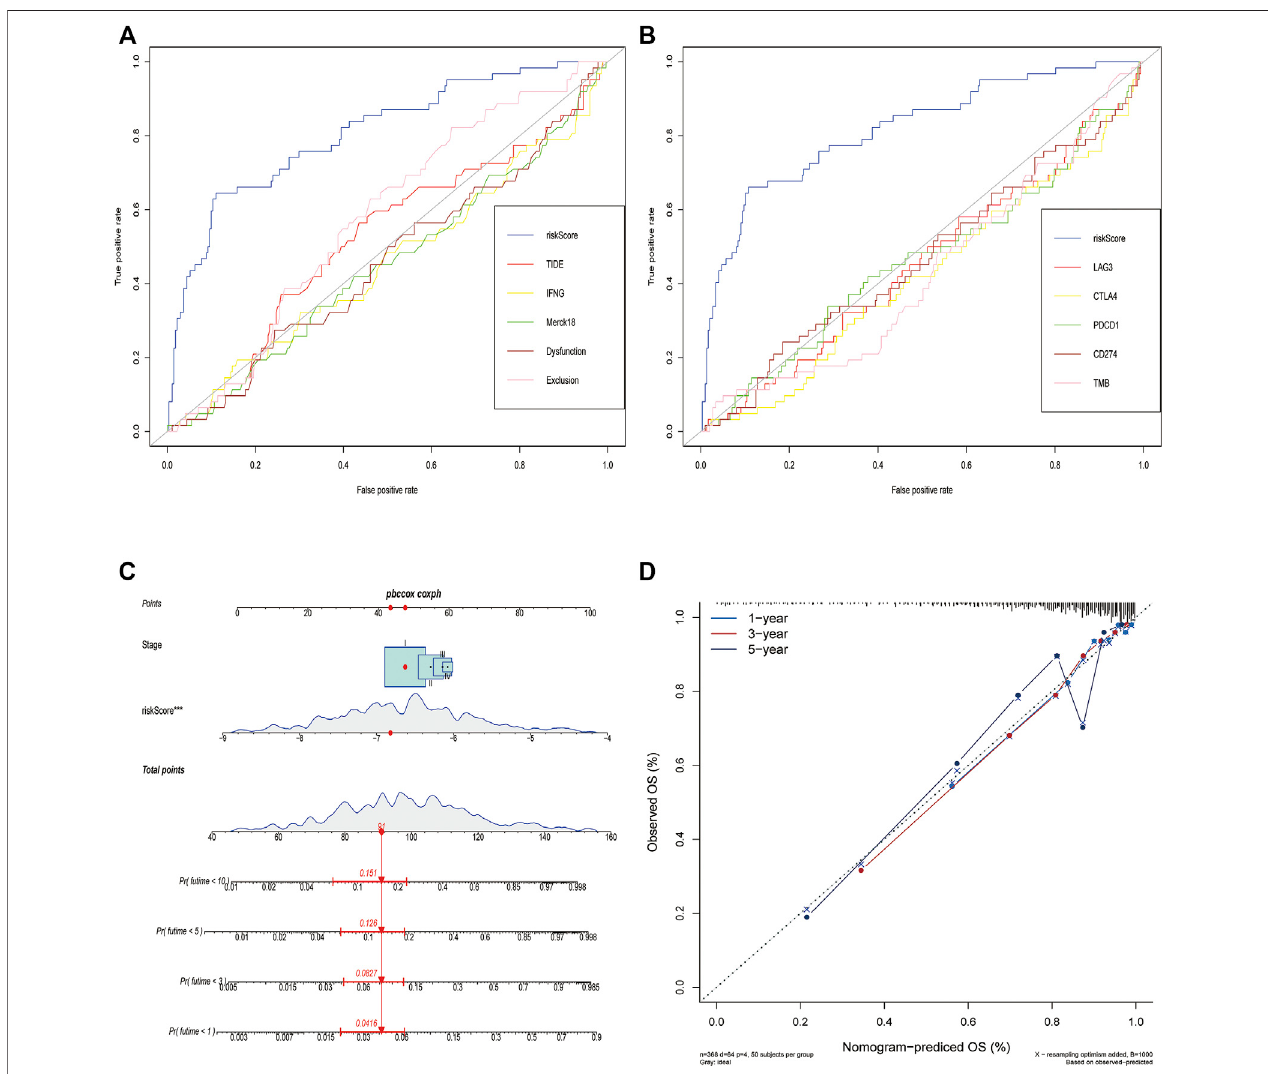
FIGURE 8 | Comparison of the predictive power of PCD-related signature with other biomarkers and construction of a nomogram in TCGA cohort. (A,B) ROC curve compared the sensitivity and speci fi city of risk score and other biomarkers for predicting OS. (C) Nomogram combined the TNM staging and risk score for predicting the 1-, 3-, 5-, and 10-years OS. (D) Calibration curves of the nomogram for predicting of 1-, 3-, and 5-years OS.